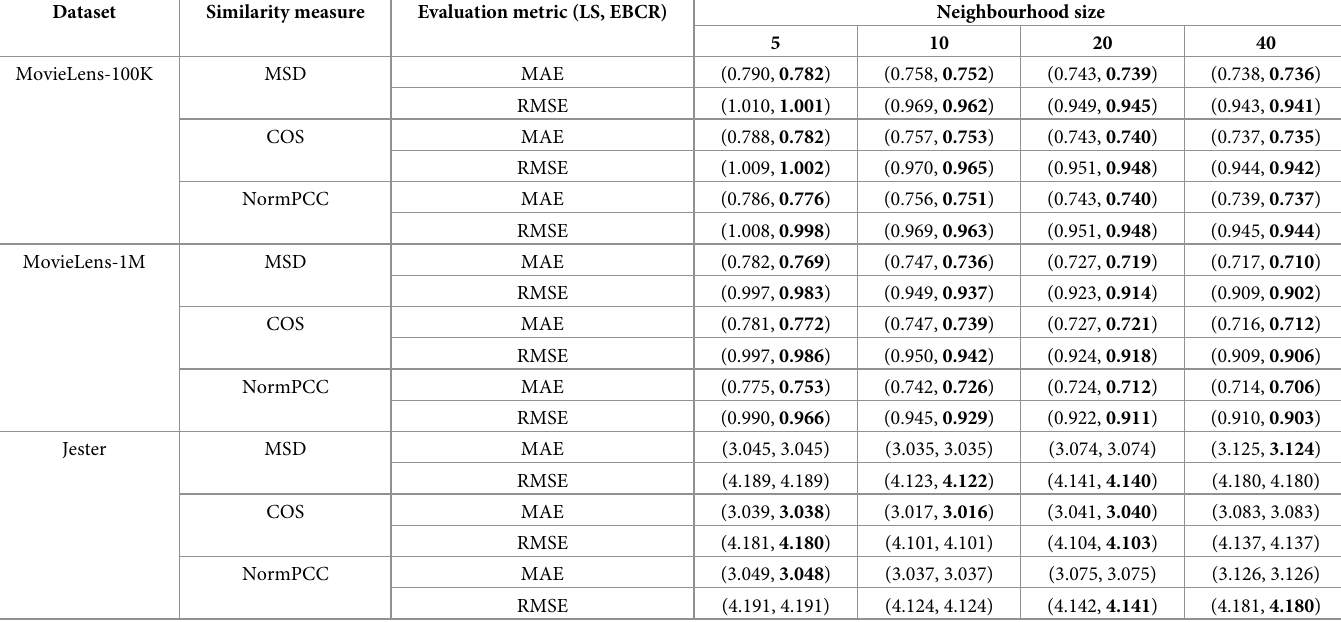
Table 2. Comparisons of the Laplace smoothing ( LS ) with the EBCR approach on three benchmark datasets: MovieLens-100K, MovieLens-1M and Jester.